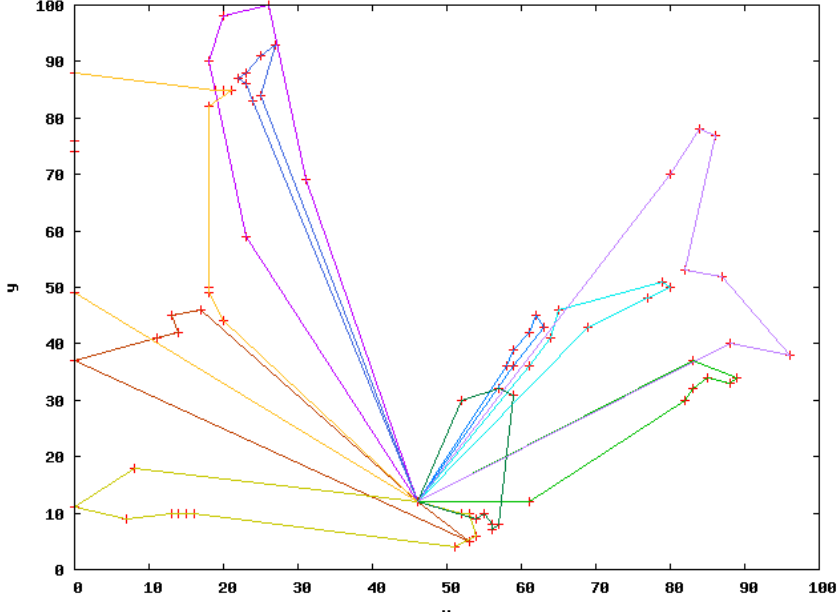
Figure 19. Best combinations, long, large examples experiment–example for largest Augerat set B, with fitness distance from the best-known one around 6.64%.